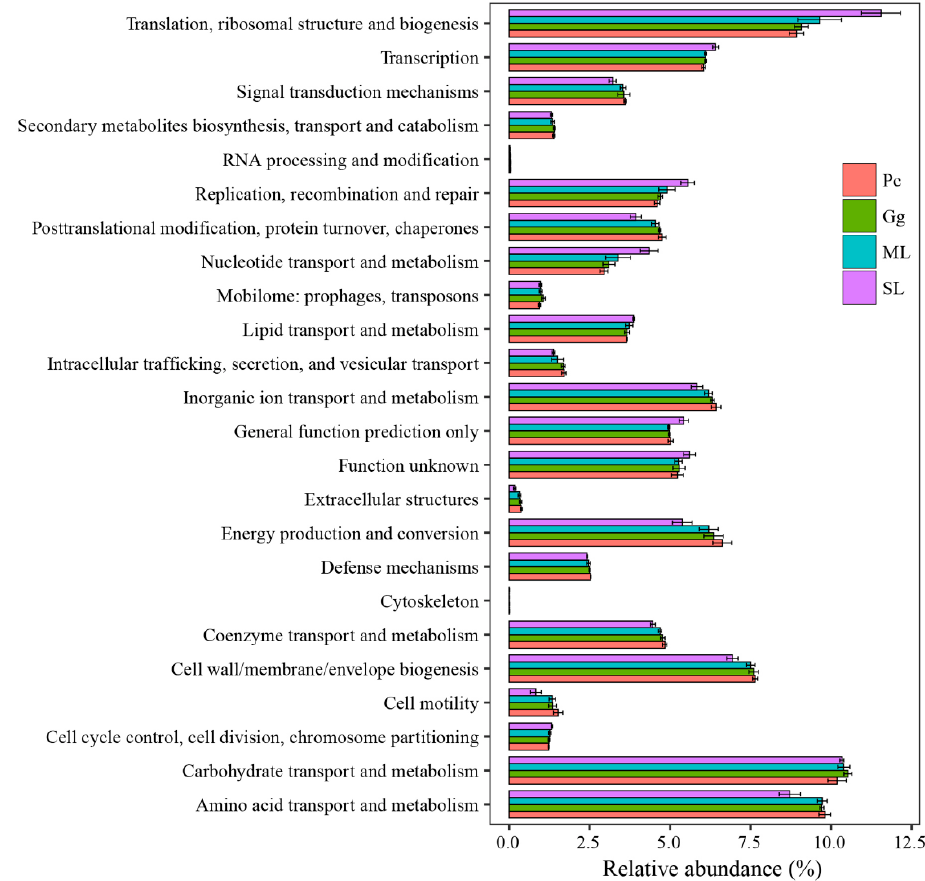
Figure 7. Comparison of predicted Clusters of Orthologous Genes (COG) functional categories of the gut bacterial community in Locusta migratoria manilensis fed on different food plants. ML: maize leaves; Gg: goosegrass; SL: soybean leaves; Pc: pakchoi.